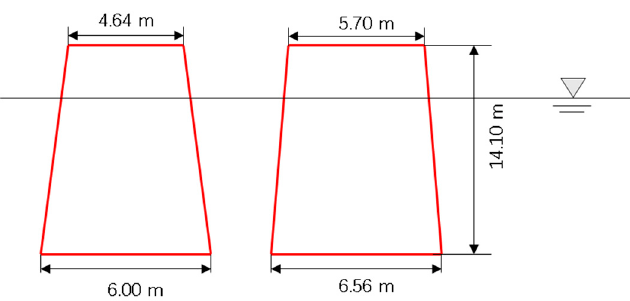
Table 4. The main parameters of wind turbines in full scale.